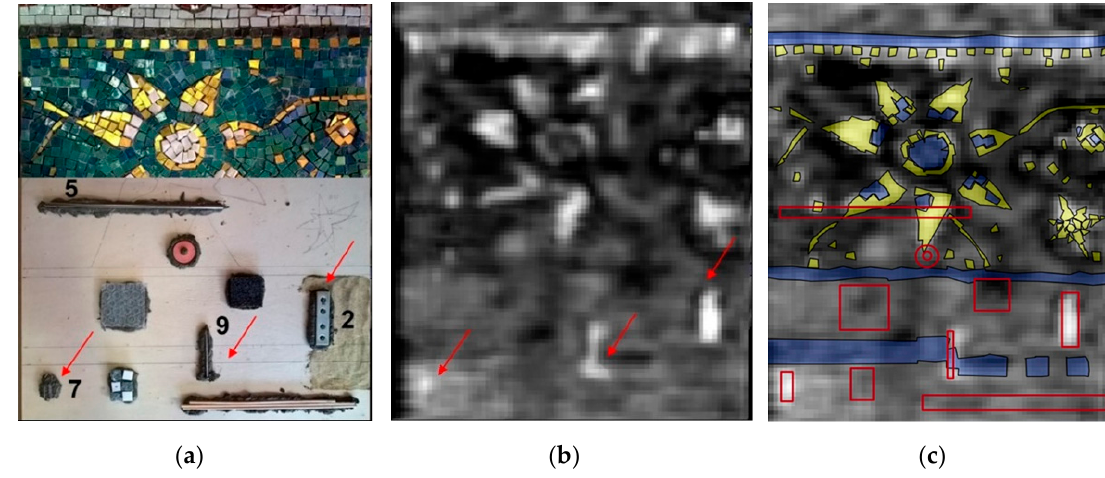
Figure 7. Holographic subsurface radar (HSR) results on a custom-built mosaic model: ( a ) Visible image showing the location of defects in the subsurface structure; ( b ) Rascan image at 6.7–6.8 GHz, where the red arrows indicate the location of the detected embedded metallic elements; ( c ) Rascan image with the location of defects (contour in red), stone tesserae (blue) and golden leaf tesserae (yellow). After Chaban et al. [73].